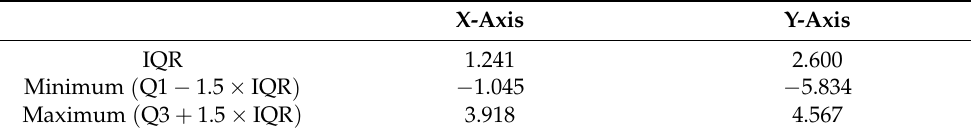
Table 5. Criteria for the upper and lower bounds using IQR.